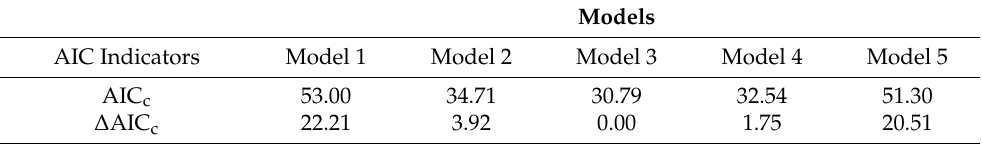
Table 9. AIC c scores and ∆ AIC c values (Model (i) versus Model